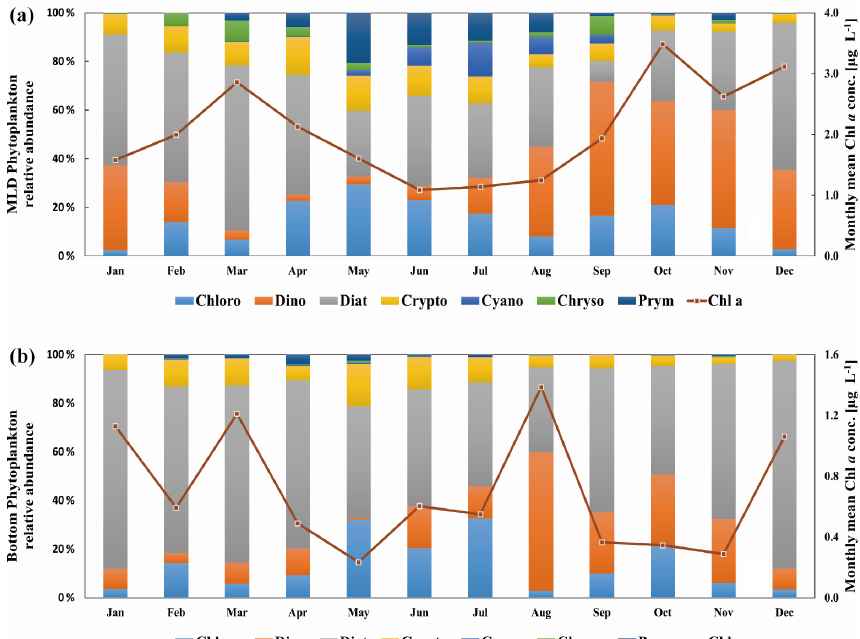
Figure 5. Monthly mean phytoplankton composition at the Boknis Eck station from 2009 to 2018 based on the result of CHEMTAX. The same months of each year were averaged. Please note that pigment samples are available from April 2009 until December 2018. The values are averaged for the mixed layer (a) and bottom layer (b) . Chloro stands for chlorophytes, dino stands for dinoflagellates, diat stands for diatoms, crypto stands for cryptophytes, cyano stands for cyanobacteria, chryso stands for chrysophytes and prym stands for prymnesiophytes. The red lines indicate monthly mean Chl a concentrations for the mixed layer and bottom layer.